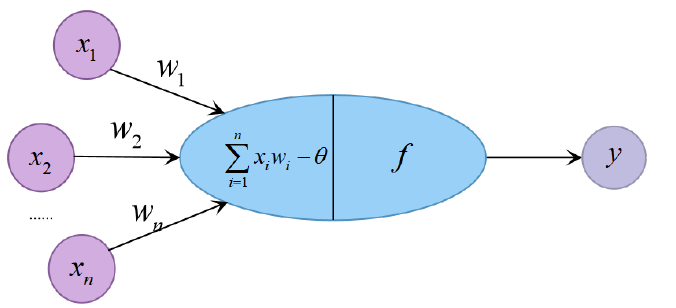
Figure 2. The schematic diagram of an artificial neural.